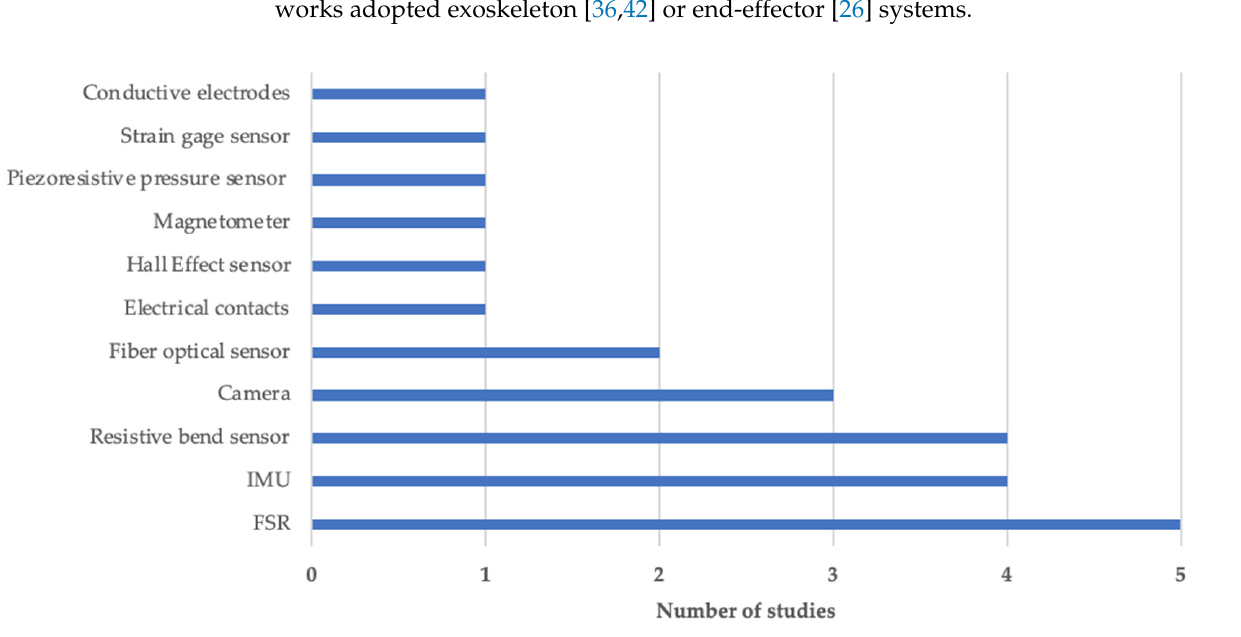
Figure 2. Sensing technology overview. Abbreviations: IMU = Inertial measurement unit, FSR= Force sensing resistor.